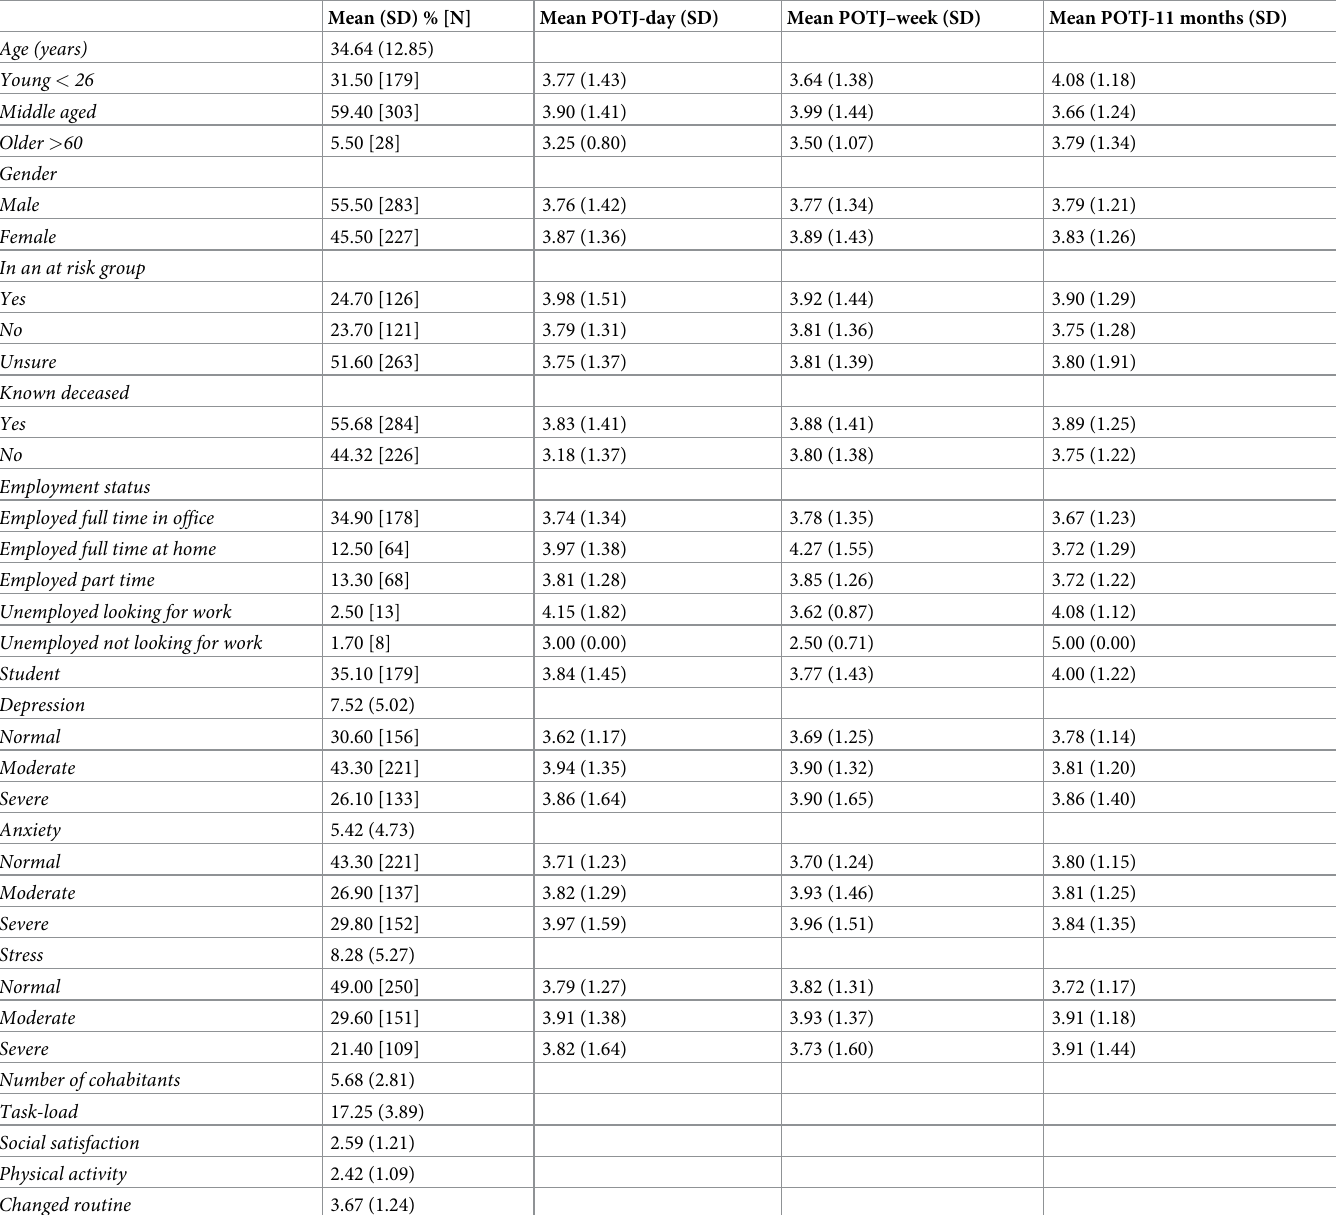
Table 1. Descriptive statistics of the proportion of participants in different demographic groups and the mean POTJ for each